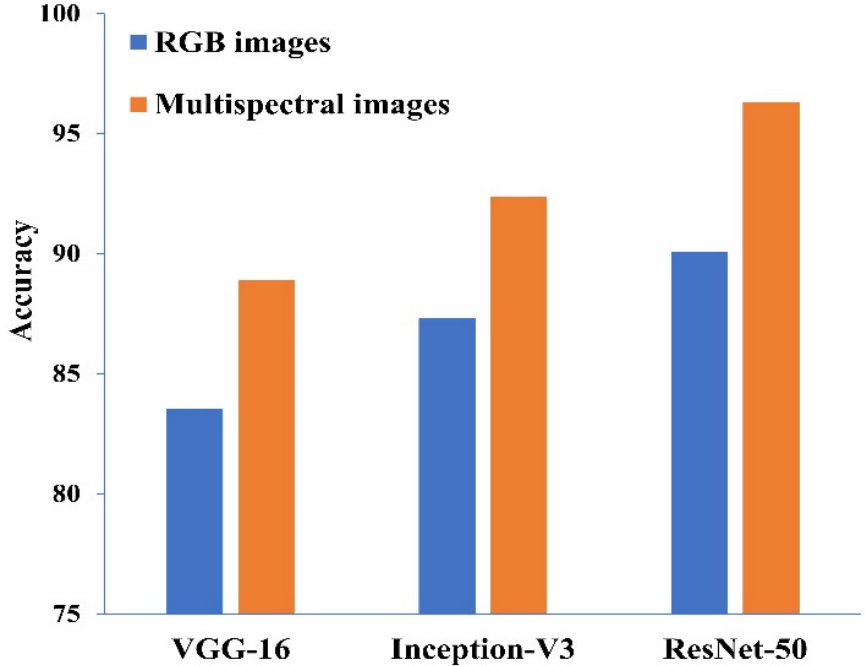
Figure 16. Classification accuracy of the three algorithms with two image